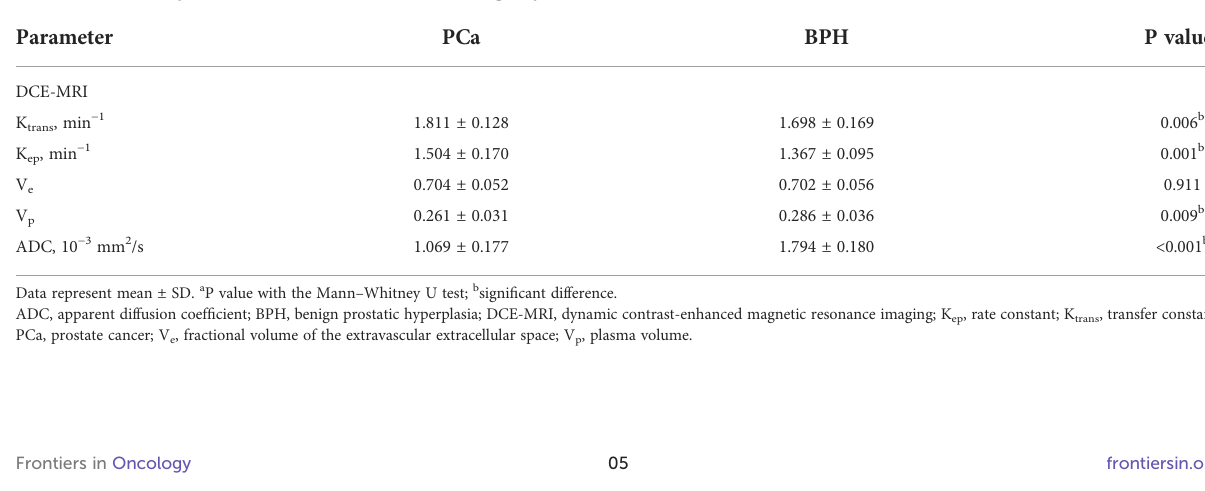
0.688 for ADC, and 0.999 for PI-RADS score (Table 3 and Figure 4A). The sensitivity values of PI-RADS, K trans , and ADC were higher than those of K ep and V p , whereas the speci fi city values of K ep , V p , and ADC were higher than those of PI-RADS and K trans (Table 3). Given the signi fi cant differences in PI-RADS score and